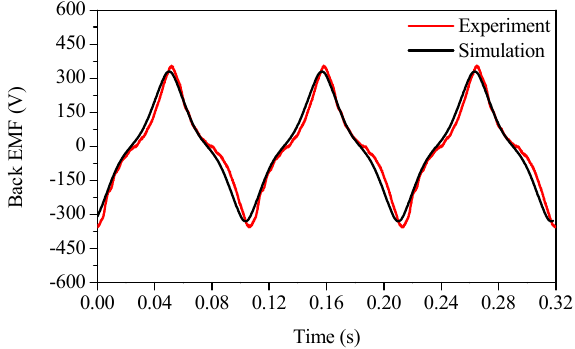
Figure 11. No-load voltage back EMF ( v rms = 0.25 m / s).